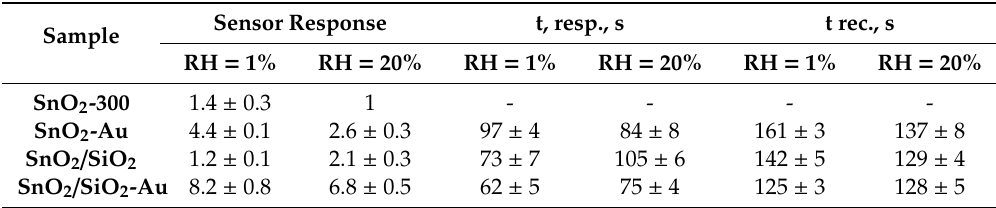
Figure 9. DRIFT spectra of SnO 2 / SiO 2 -Au during C 2 H 5 OH exposure at 300 ◦ C in dry and humid air (RH = 20%). Table 6. Sensor properties of SnO 2 -300, SnO 2 -Au, SnO 2 / SiO 2 and SnO 2 / SiO 2 -Au towards 100 ppm C 6 H 6 at 300 ◦